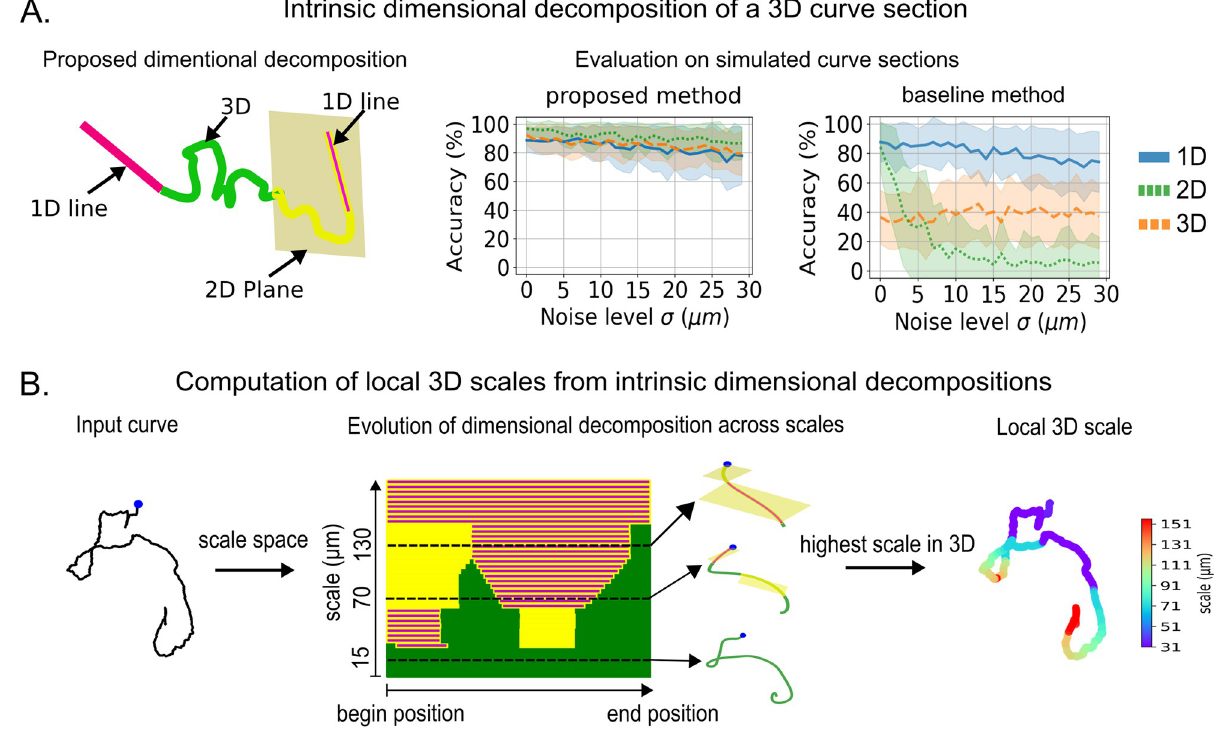
Fig 1. Computation of the 3D local scale of neuronal traces from their multiscale dimensionality decomposition. (A) (left) Variation of the intrinsic dimensionality along a portion of 3D curve; (right) evaluation of the decomposition on simulated trajectories comparing to a baseline method [37, 38]. Shown is the accuracy of the decomposition of each method for each dimension as additional noise is added on the simulated curve. (B) Schematic presentation of the processing of 3D curves by the nAdder algorithm.